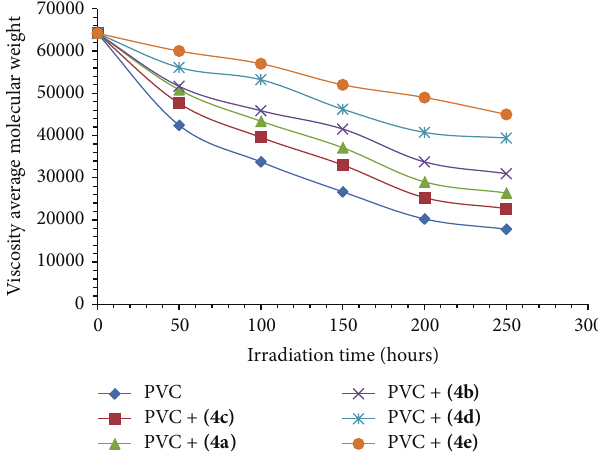
Figure 4: The relationship between the alkene index and irradiation time for PVC films (30 𝜇 m thickness) with or without additives 4a–e (0.5% by weight).